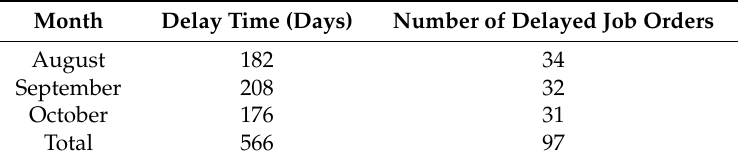
Note: N = Production (reassembly) starting time. Table 3. The reassembly delay time (August 2015 to October 2015). Month Delay Time (Days)